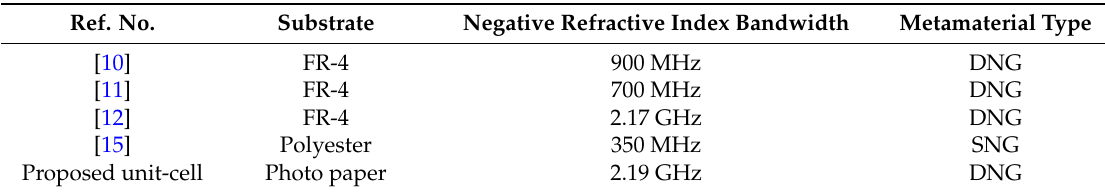
Table 2. Comparison of the proposed unit cell with other unit-cells.